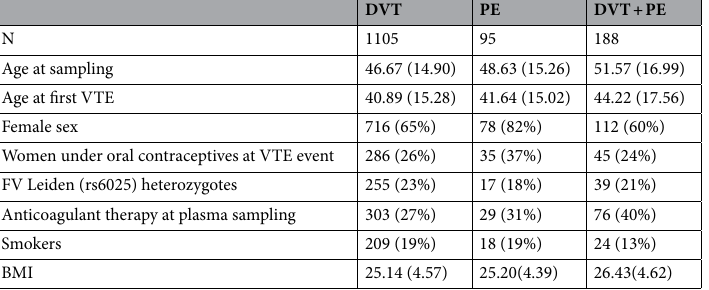
Table 1. Characteristics of the MARTHA proteomics study. Data shown correspond to mean (standard deviation) and count (percentage) for continuous and categorical variables, respectively. DVT Deep Vein Thrombosis, PE Pulmonary Embolism, BMI Body Mass Index.